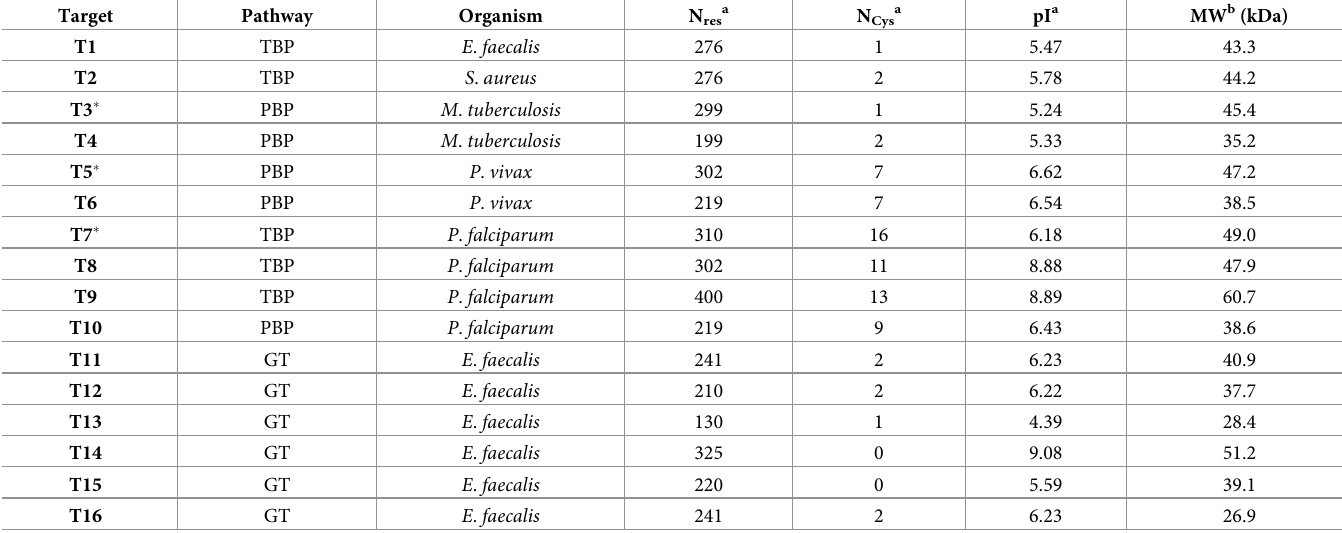
a Applies to the target sequence, without considering the fusion protein sequence. b Molecular mass computed with the fusion tag. expression was also observed in E . coli Rosetta